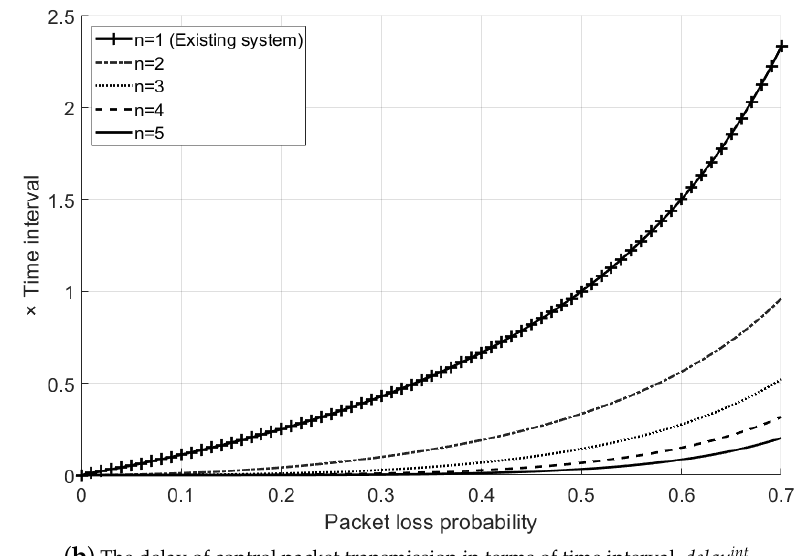
Figure 7. Analysis of the delay when using MuTran in